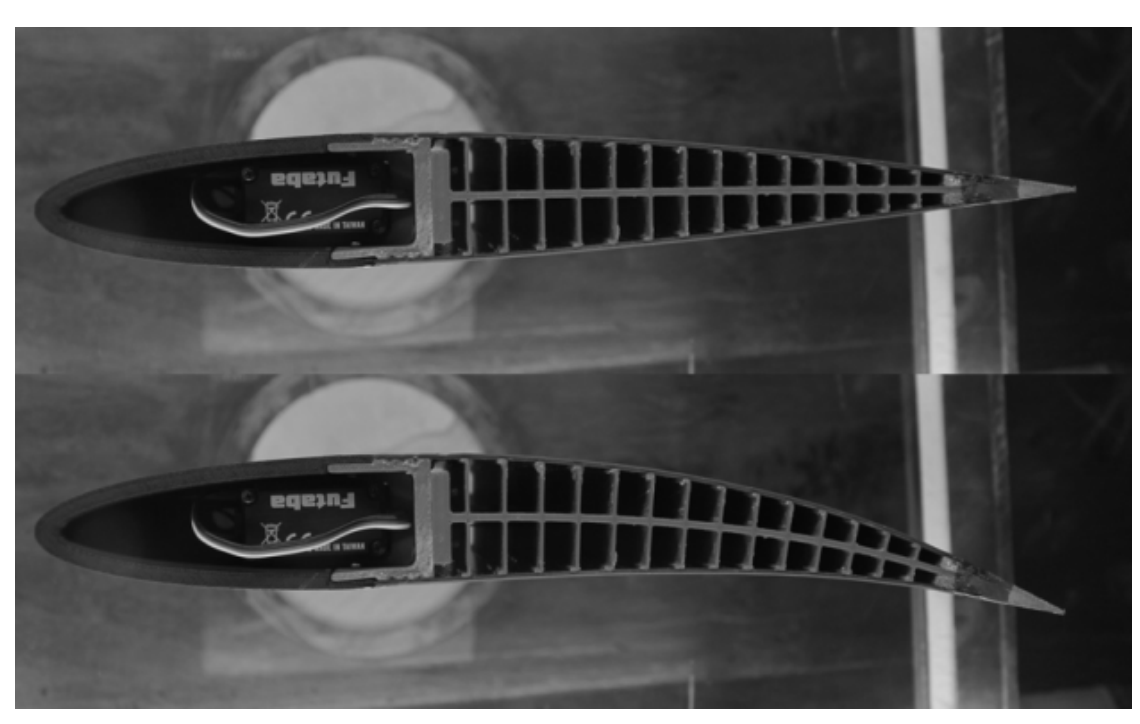
Figure 3. FishBAC wind tunnel test model showing baseline and morphed